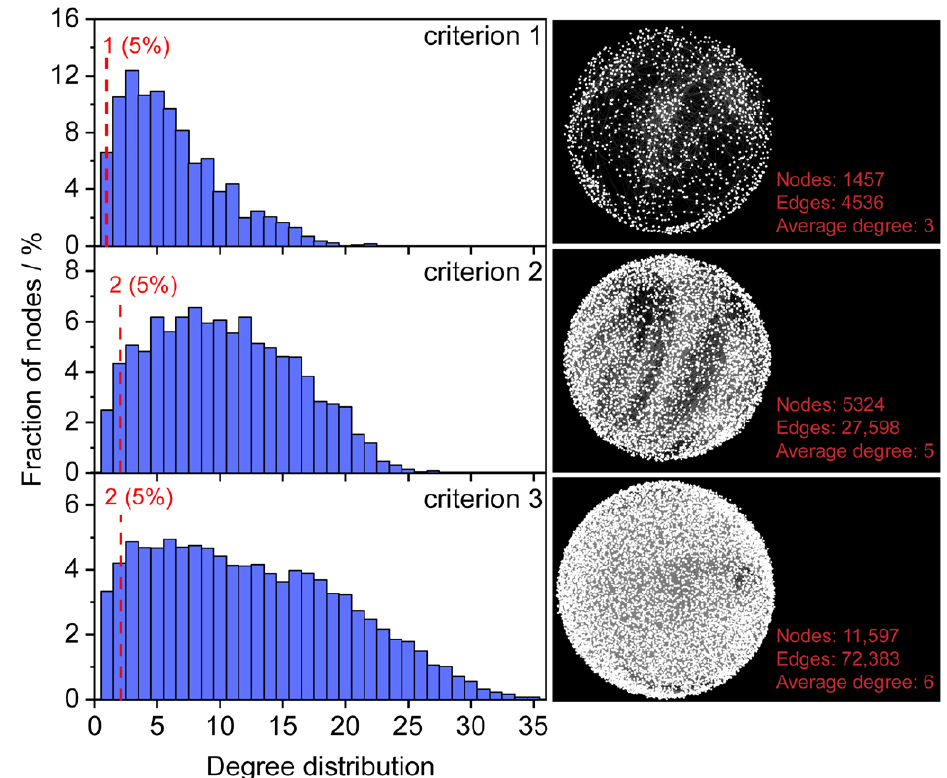
Figure 2. Degree distributions of seed nodes in the initial network. Criterion 1 represents endogenous metabolites from blood (1650), criterion 2 represents endogenous (5620) and criterion 3 represents all metabolites in the HMDB (12,351).